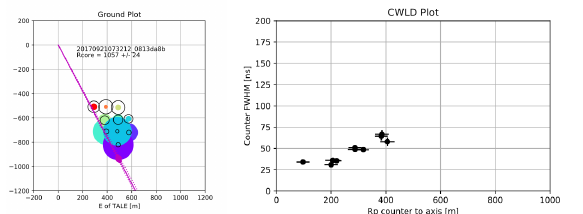
Figure 5. Left: The time vs angle plot of a hybrid time fit. The TALE measurements are shown in black. The various shower- detector-plane angle expectations are shown in green to blue lines. The projection of the NICHE times onto the shower axes are also shown in green to blue points. The best fit time-vs- angle line and NICHE points are shown in red. Right: The χ 2 - distribution of the fit versus the SDP-angle ψ .